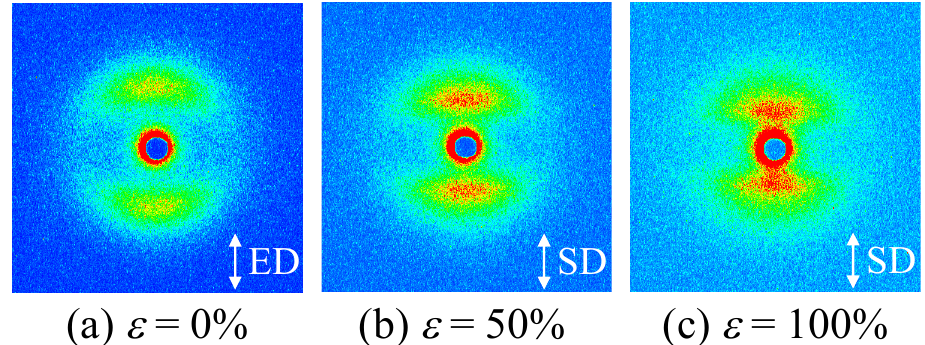
Figure 7. Two-dimensional SAXS patterns of the heat-elongated TPU film ( λ = 300%) during uniaxial stretching at various strains ε at 23 °C; ( a ) ε = 0%, ( b ) ε = 50%, ( c ) ε = 100%. ED is elongated direction and SD is stretching direction.